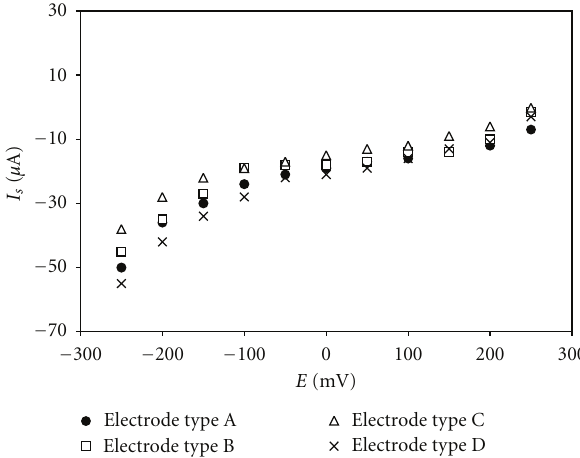
Figure 1: Steady-state current as a function of the applied potential at modified glassy carbon electrodes in 0.1MH 2 O 2 present; phos- phate-citrate bu ff er, pH 7.0; reference electrode Ag/AgCl (1MKCl); temperature 25 ◦